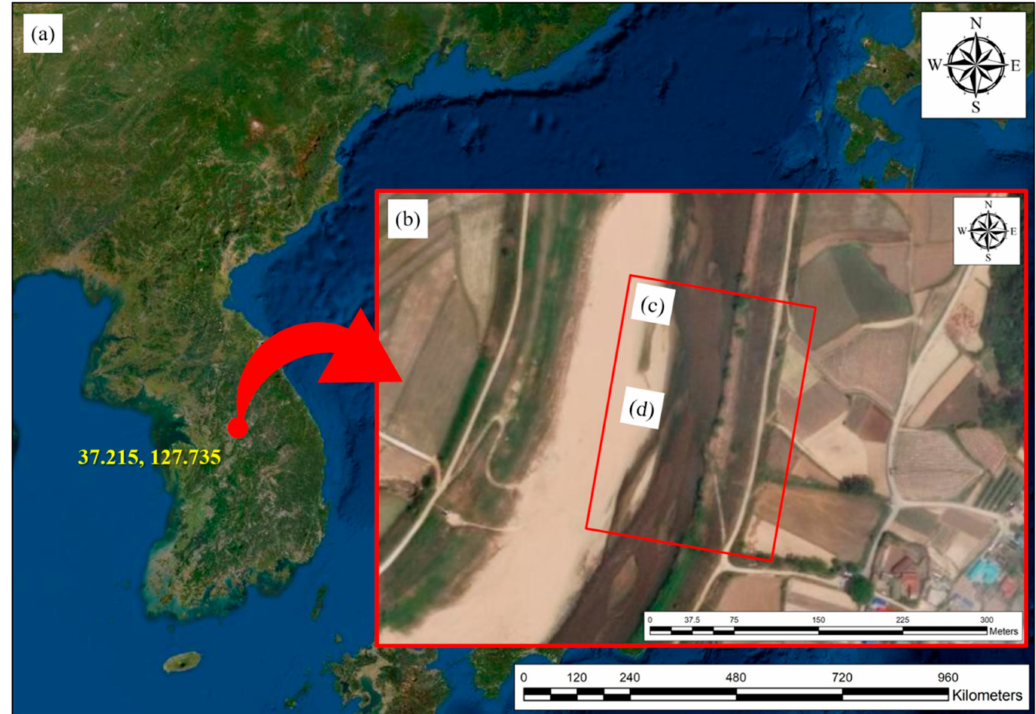
Figure 7. Study area, showing: ( a ) general location; ( b ) Cheongmi Stream site; ( c ) data collection passage; ( d ) image area used for